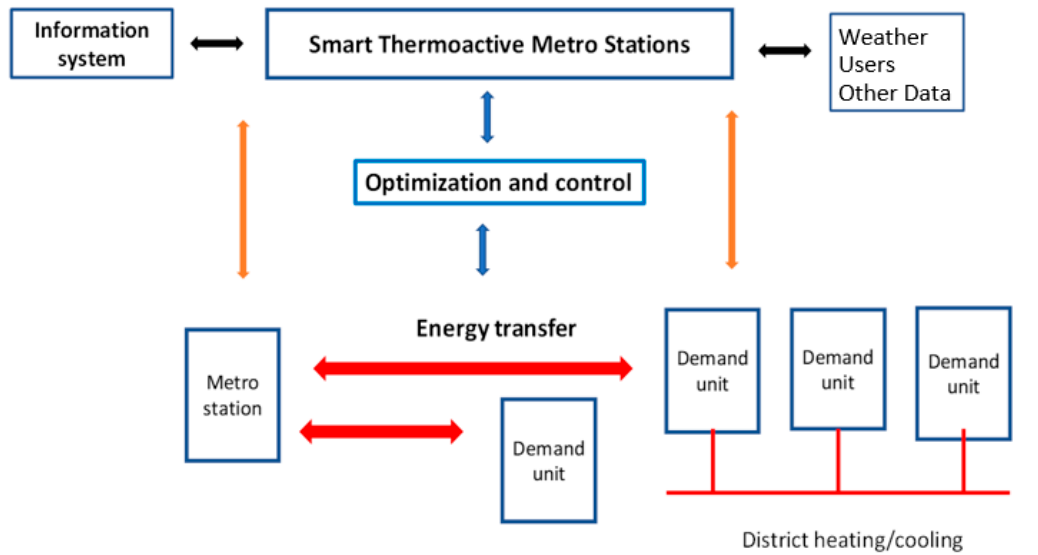
Figure 2. Integration of the metro stations’ thermal energy into the global energy system, using smart technology.